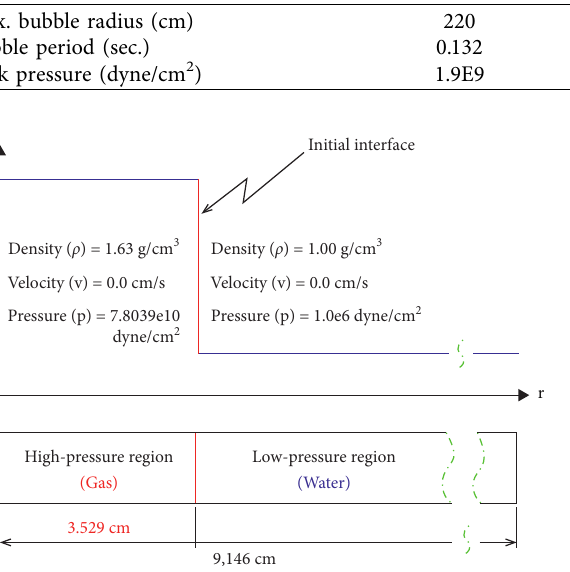
Figure 19: Initial conditions of Case 6.